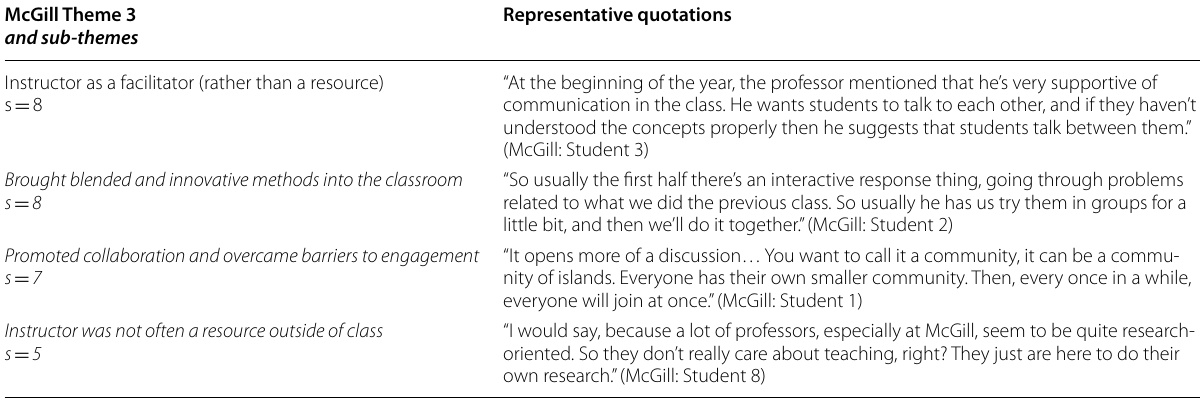
Table 5 McGill institutional analysis—Theme 3 McGill Theme 3 and